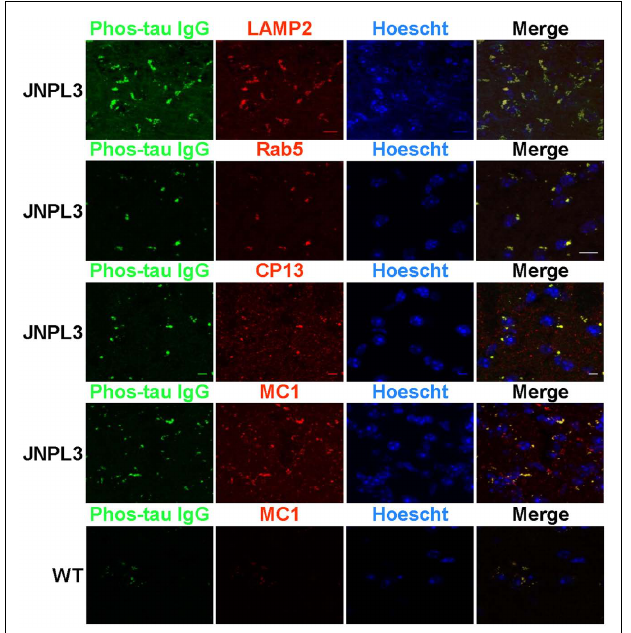
FIGURE 1 | FITC labeled IgG from a high titer mouse co-localizes with phosphorylated and pathological tau within the endosomal/lysosomal system. Confocal microscope images of brain slice sections from JNPL3 transgenic mice andWT (bottom panel) mice. Slices were incubated with FITC–IgG from a high titerTau 379–408[pSer 396,404 ] immunized mouse (green) and after sectioning co-stained with an antibody to LAMP2 (red), a marker of late endosomes/lysosomes, and an antibody to Rab5 (red), a marker of early endosomes and the nuclear stain Hoechst 33342.The merged images indicate areas of co-localization between FITC–IgG and endosomes and lysosomes (orange/yellow), mostly in perinuclear areas. Slices were also co-stained with an antibody to MC1 (red), which recognizes a disease related conformational tau epitope and CP13 (red) which recognizes tau pSer202.The merged images indicate areas of co-localization between FITC–IgG and pathological tau (yellow), mostly in perinuclear areas. Minimal staining was observed in theWT mouse. Scale bar = 10 μ m.